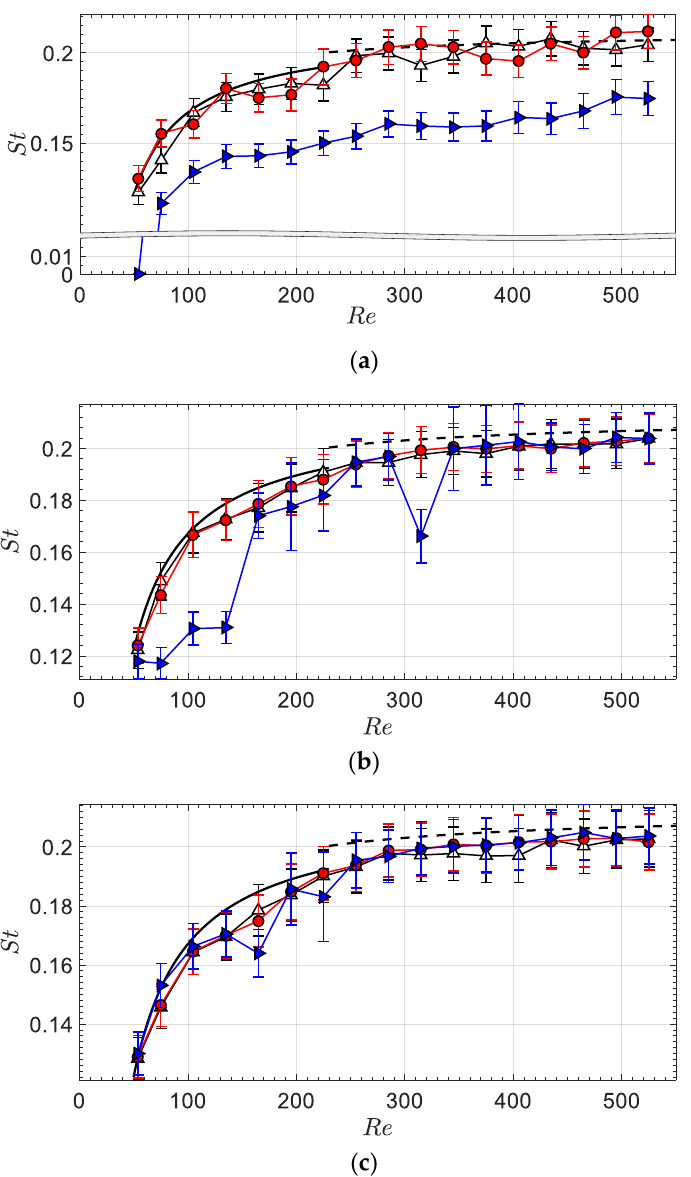
Figure 5. Experimental setup validation: Strouhal number versus Reynolds number for the smooth Figure 8. Strouhal number versus Reynolds number along the bent cylinder inclined leg at different circular cylinder in cross-flow: fixed-fixed cylinder ( a ), and bent cylinder in its asymptotic limiting inclinations: 90° ( a ); 75° ( b ); 60° ( c ). Symbols : 𝑠/𝐿 𝑖 = 0 (△),0.5(○), 1(⊳) . Continuous line: Equation (3); configuration at 90° yaw angle ( b ). Symbols: 𝑠/𝐿 (cid:3036) (cid:3404) 0 (cid:4666)△(cid:4667), 0.5(cid:4666) ○ (cid:4667) . Continuous line: inclinations: 90 ◦ ( a ); 75 ◦ ( b ); 60 ◦ ( c ). Symbols: s / L i = 0 ( (cid:52) ) ,0.5 ( Dashed line: Equation (4). Equation (3); Dashed line: Equation (4). (3); Dashed line: Equation